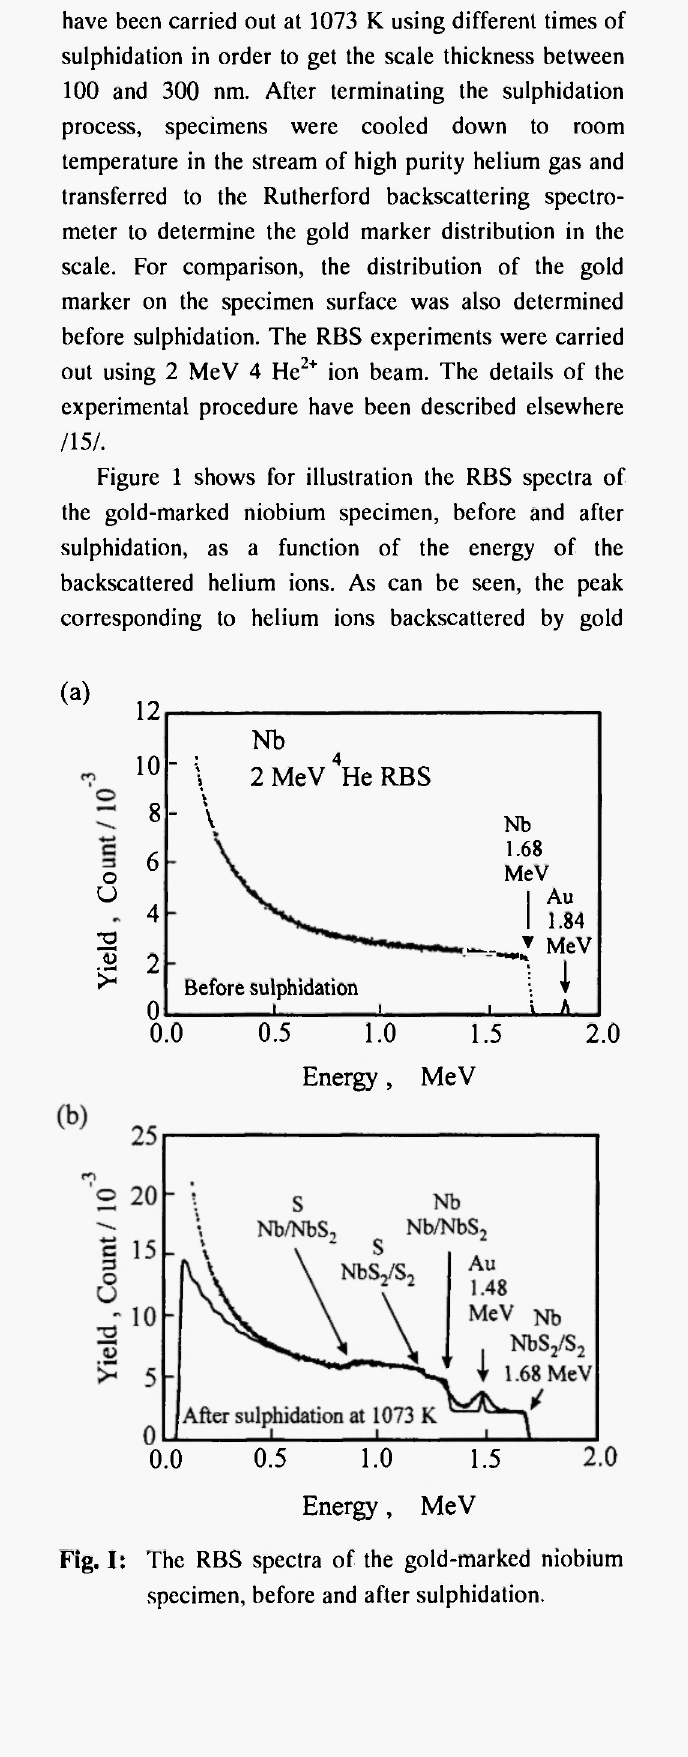
The RBS spectra of the gold-marked niobium specimen, before and after